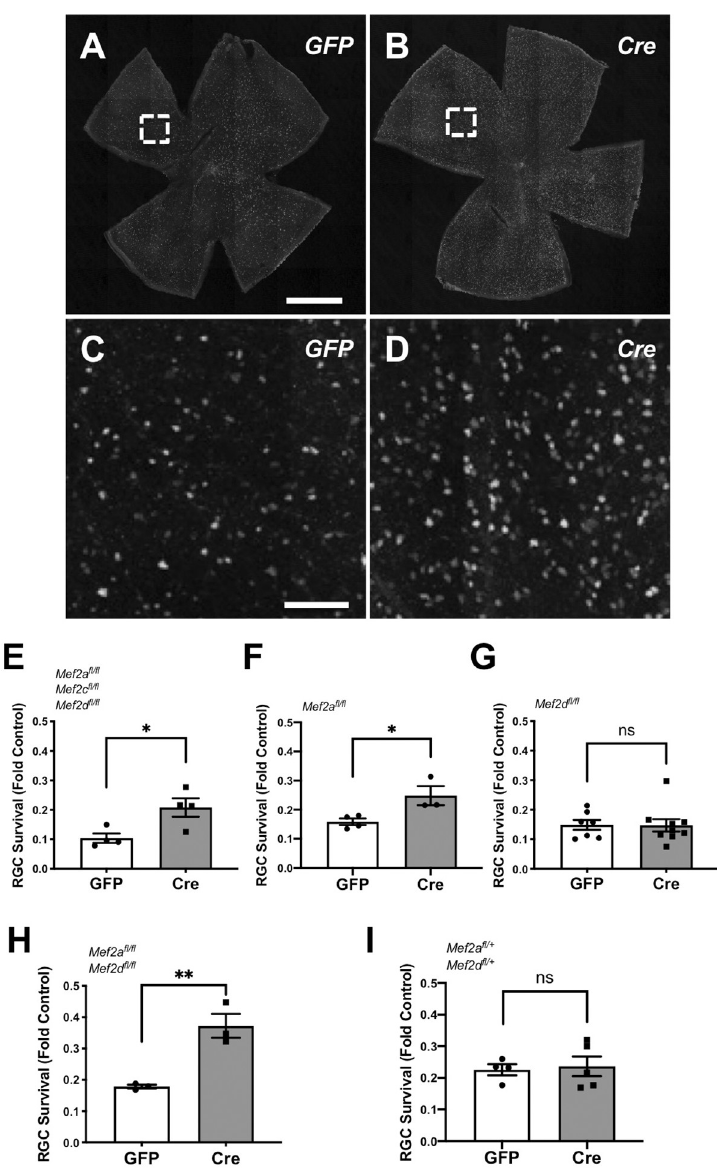
Fig 3. Mef2a gene targeting promotes RGC survival after optic nerve crush. (A-D) Representative images of RBPMS-positive RGCs from Mef2a f/f ; Mef2d f/f mice injected with either AAV2-cre-GFP or AAV2-GFP control (scale bar in A, B, 1 mm; in C, D, 100 μ m). (E-I) Mice of the indicated genotypes injected with either AAV2-cre-GFP or AAV-GFP control were subjected to optic nerve crush. RBPMS expressing cells were quantified two weeks later. RGC counts are normalized by the number of RGCs in the contralateral non-crushed eye. Each datapoint represents an individual mouse. Data were analyzed by Student’s t -test. Mef2a knock-out increased RGC survival 1.5-fold compared with control eyes; Mef2a/d double knock-out and Mef2a/c/d triple knock-out increased RGC survival ~2-fold compared with control eyes. Mef2d knock-out and hemizygous Mef2a/d deletion had no significant (ns) effect on RGC